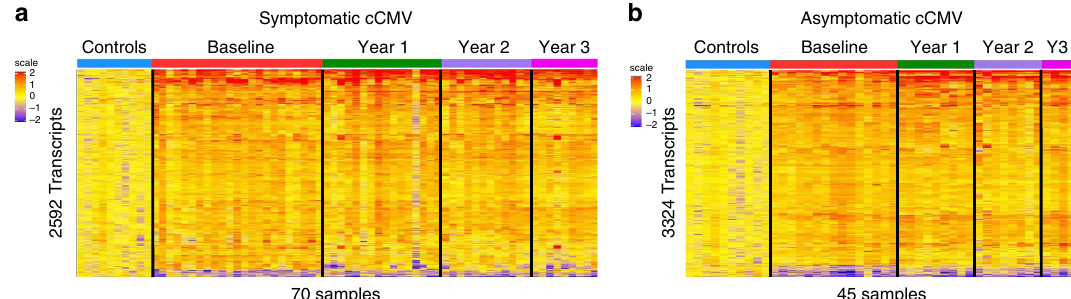
Fig. 5 Longitudinal transcriptional analysis of infants with cCMV infection. a The symptomatic biosignature (2592 transcripts) was applied to sympto- matic cCMV-infected infants with samples collected at initial testing ( n = 23), 1 year ( n = 16), 2 years ( n = 12) and 3 years ( n = 9) of follow-up. b The asymptomatic cCMV biosignature (3324 transcripts) was also applied to asymptomatic cCMV infants with samples collected at initial testing ( n = 15), 1 year ( n = 9), 2 years ( n = 8), and 3 years ( n = 4) of follow-up. Transcripts were organized in a heatmap format where each row represents a transcript and each column represents a patient sample. Red color indicates overexpression and blue color underexpression of a transcript compared with the median expression of healthy controls